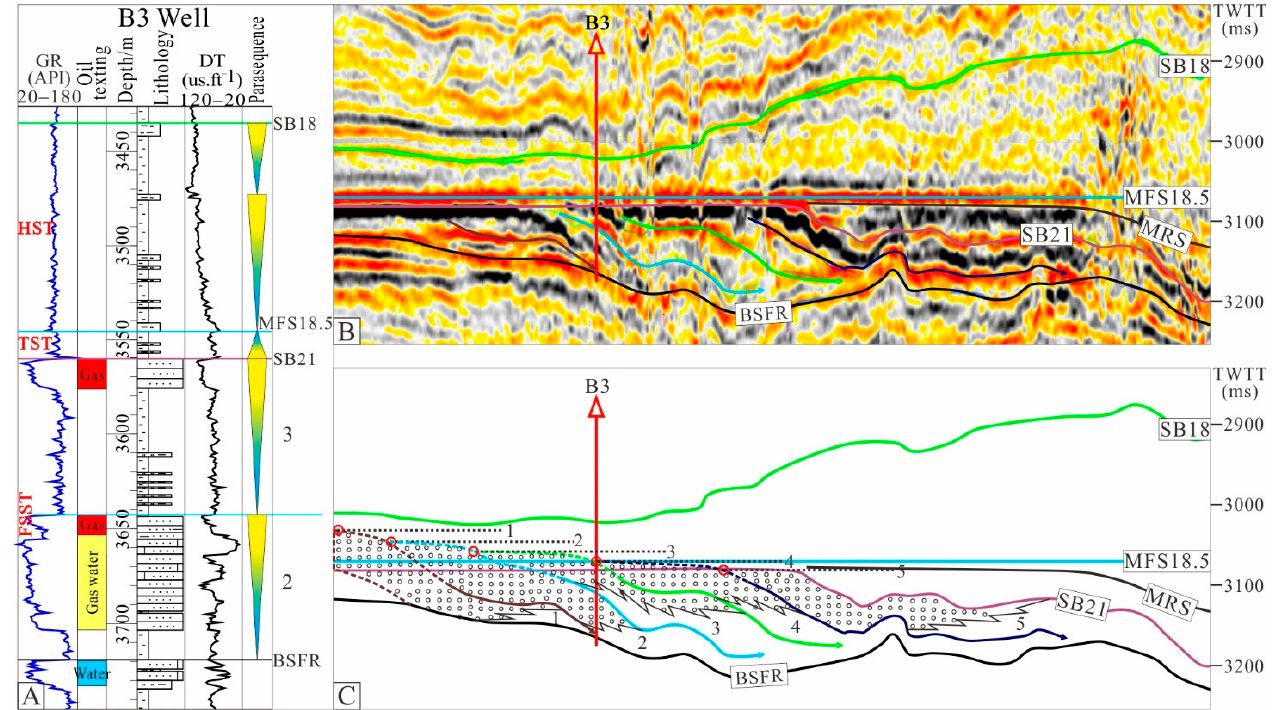
Figure 10. Depositional features and shoreline migration trajectory of falling stage systems tract: ( A ) Sedimentary sequence characteristics of single well. ( B ) Seismic reflection features of falling stage systems tract in the depositional trends (location of section is given in Figure 1B). ( C ) Seismic profile interpretation results of falling stage systems tract and reconstruction of shoreline migration trajectory.